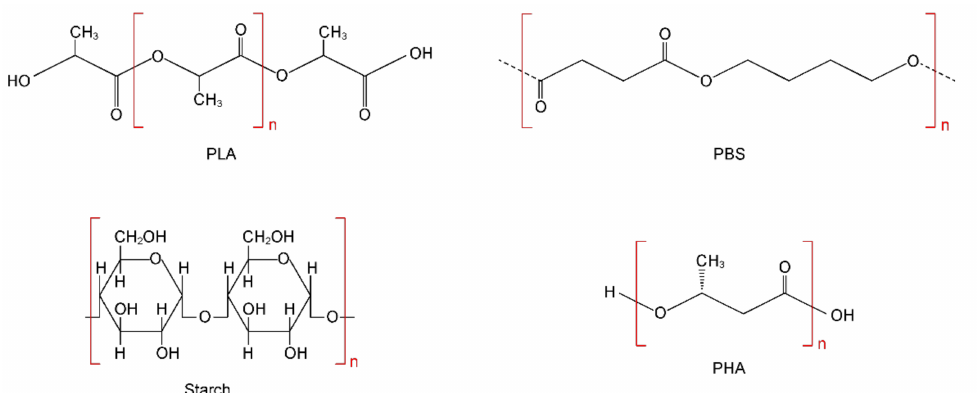
Figure 2. Structural formulas of some biodegradable